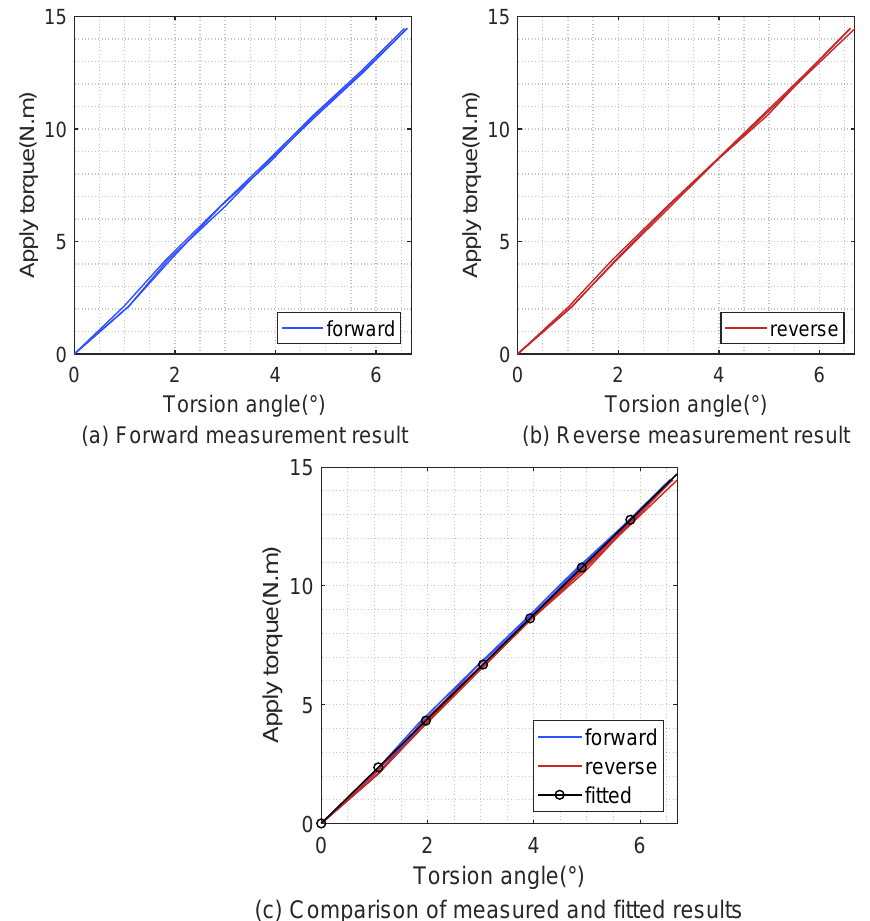
Figure 3. Spring stiffness fitting